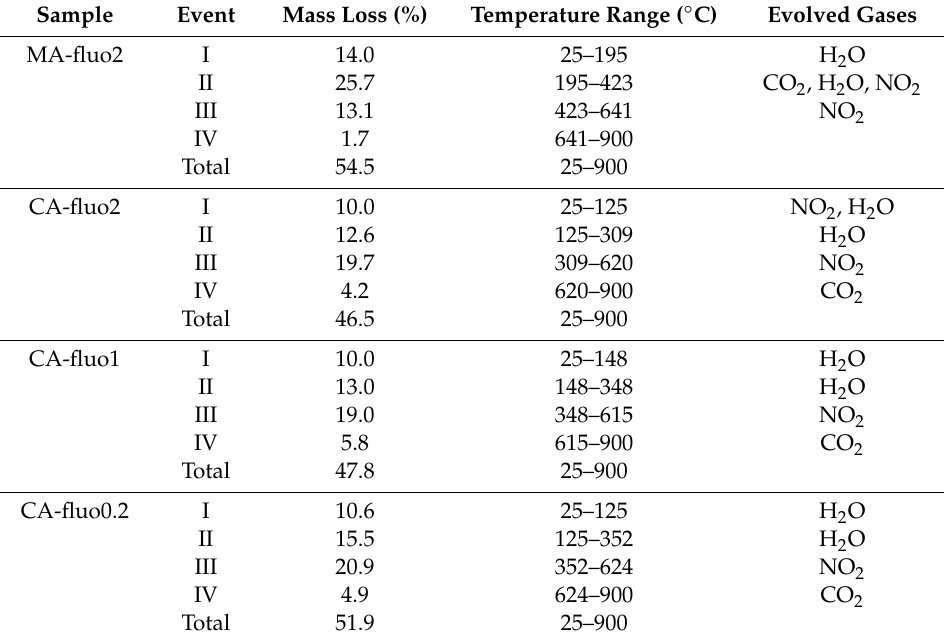
Table 3. Mass losses and gases released at each event during the thermal decomposition of the studied